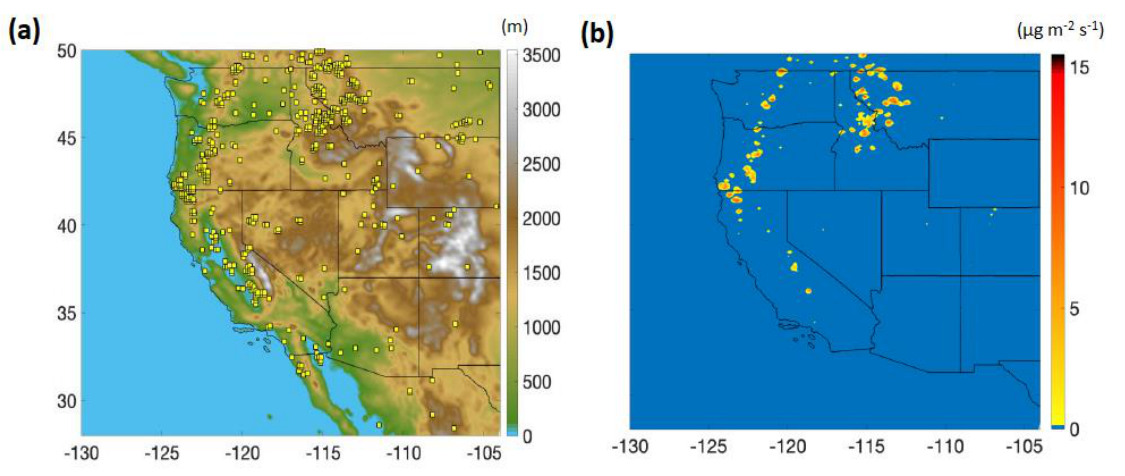
Figure 1. ( a ) Model domain and terrain height (in meters); wildfire locations for September 2017 are also shown in yellow markers; ( b ) Average PM 2.5 emissions ( µ g m − 2 s − 1 ) from the wildfires in September 2017.